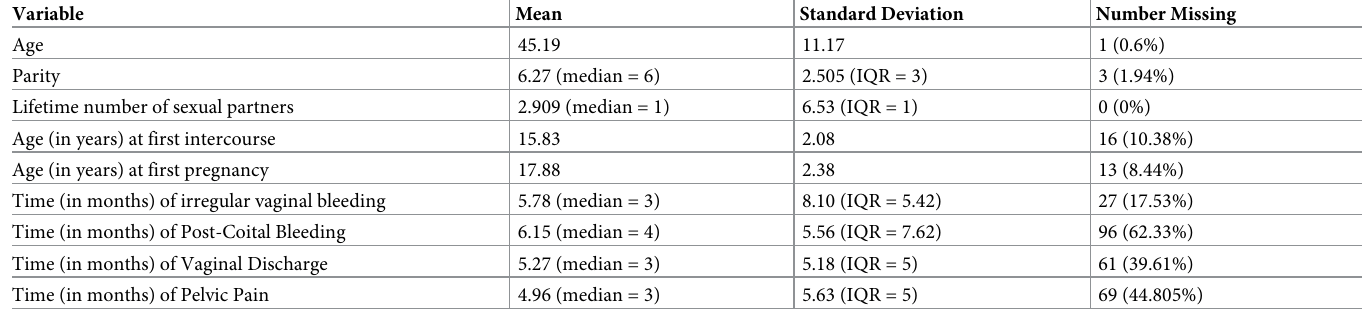
Table 1. Selected demographic and clinical features of 154 cervical cancer cases at the Jimma University Teaching Hospital, Ethiopia from January 2008—December 2010.